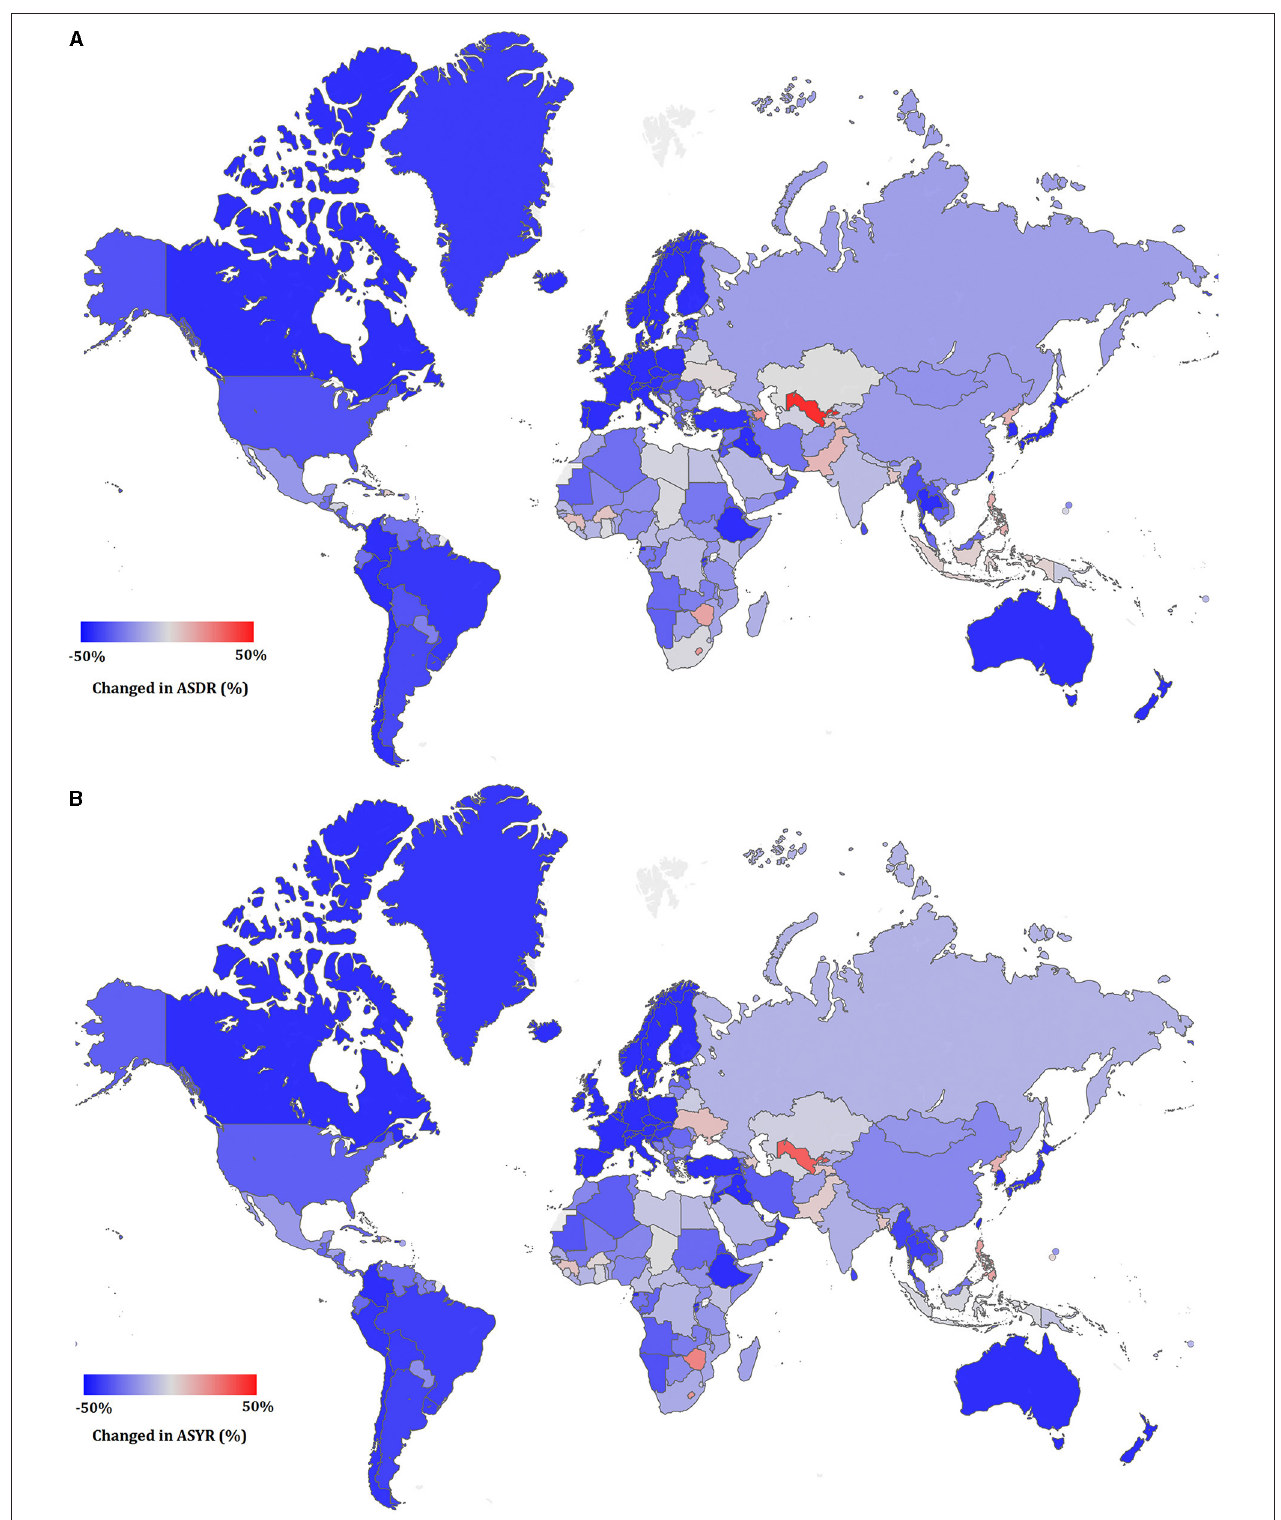
FIGURE 6 | The relative change in ASDR (A) and ASYR (B) of cardiovascular disease between 1990 and 2017.